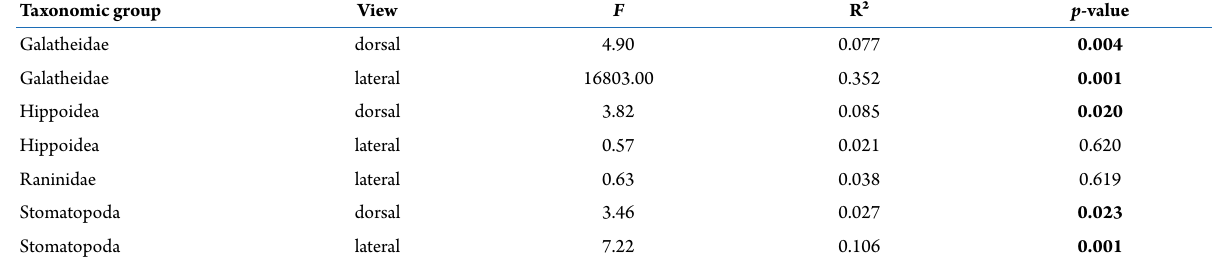
Table 2. Results of permutational multivariate analysis of variance (PERMANOVA) on “average displacement” scores of wild-caught vs. laboratory specimens. Significant p-values are marked in bold. Abb.: F: pseudo F-statistic; R²: proportion of explained variation.